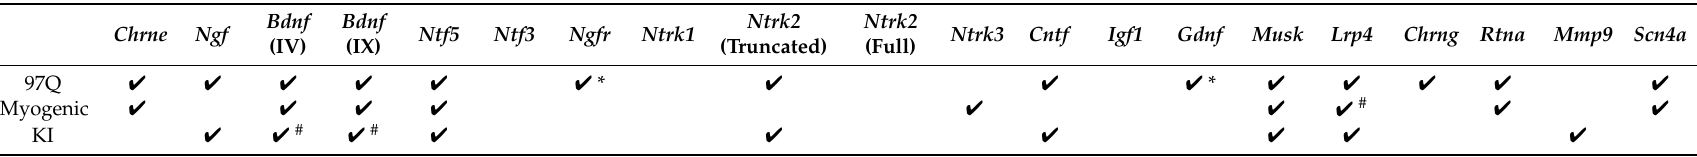
Table 1. Cross model comparison of disease-affected genes from this study. * indicates differential effects of disease on synaptic and extrasynaptic regions. # indicates directional difference from other